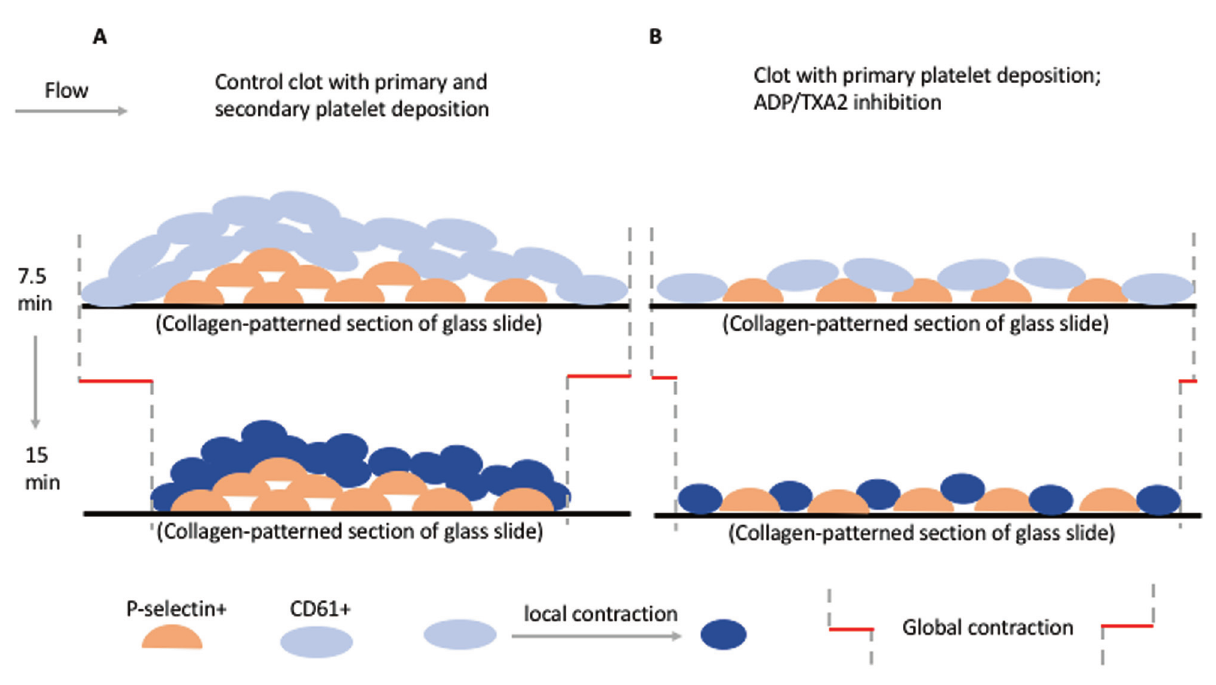
Fig. 6 Schematic of clot development and contractile processes under control conditions (A) and with ADP/TXA2 inhibitors present (B).